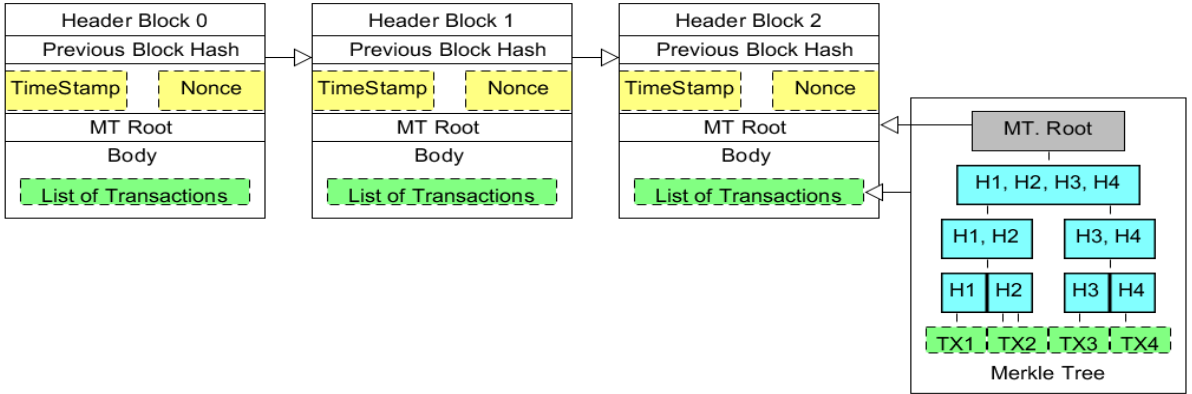
Figure 1. Blockchain construction.